Question: Condense the content of this figure into a single sentence.
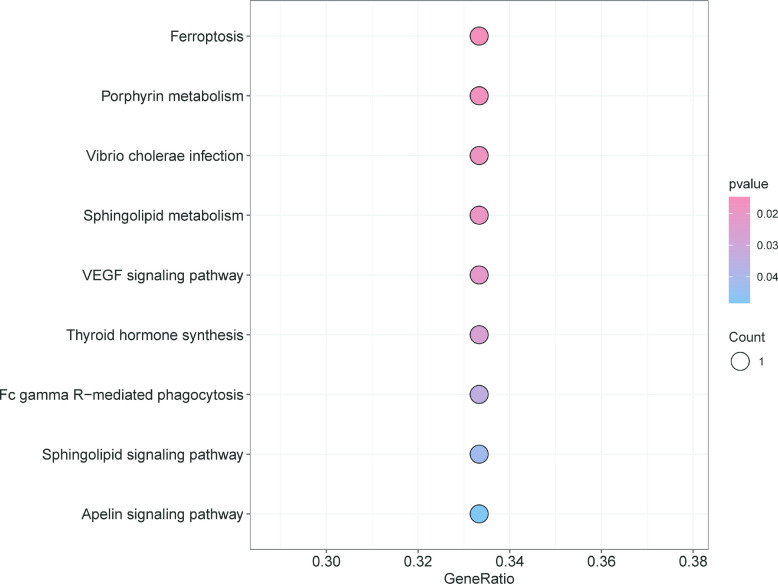
Answer: Bubble chart of KEGG enrichment. The bubble color corresponds to the P -value, and the bubble size reflects the number of enriched genes